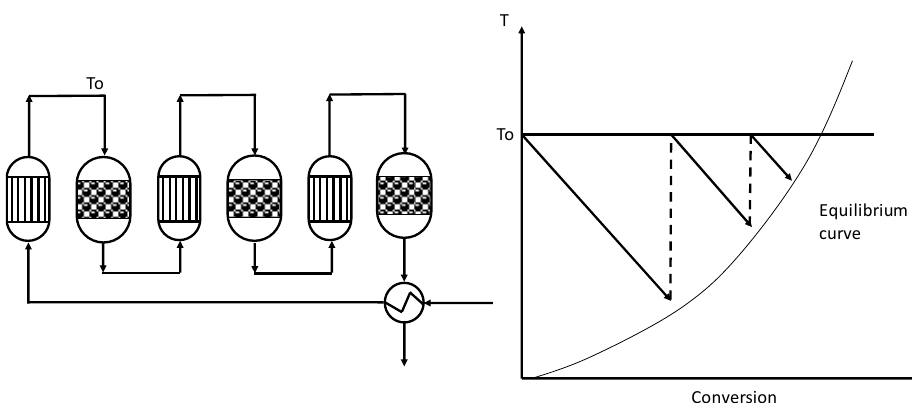
Figure 12. Scheme of a multistage adiabatic reactor (exothermic reaction). ( left ) reactor setup; ( right ) temperature profile.